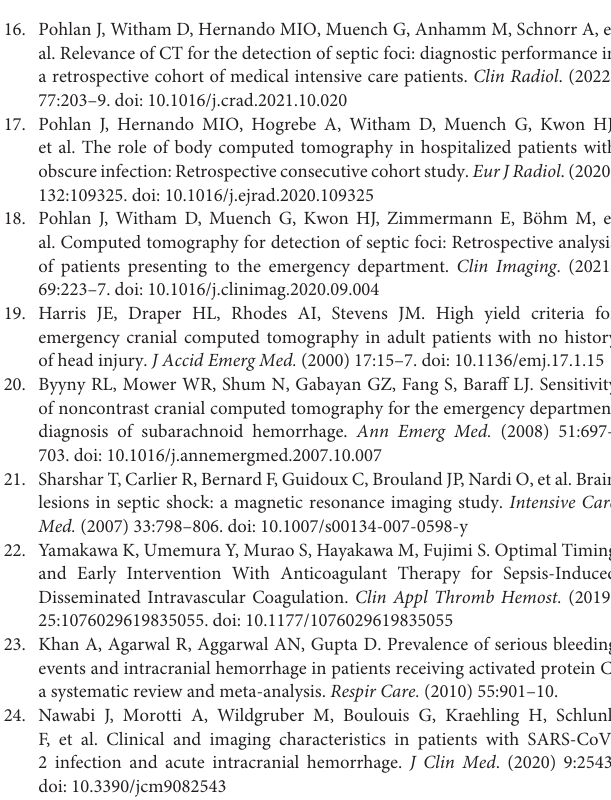
subdural hematoma (C) ; right superficial intracerebral bleeding with associated subarachnoid bleeding due to previously unknown mass lesion (D) . The patient in (B) died during the hospitalization, whereas all other patients